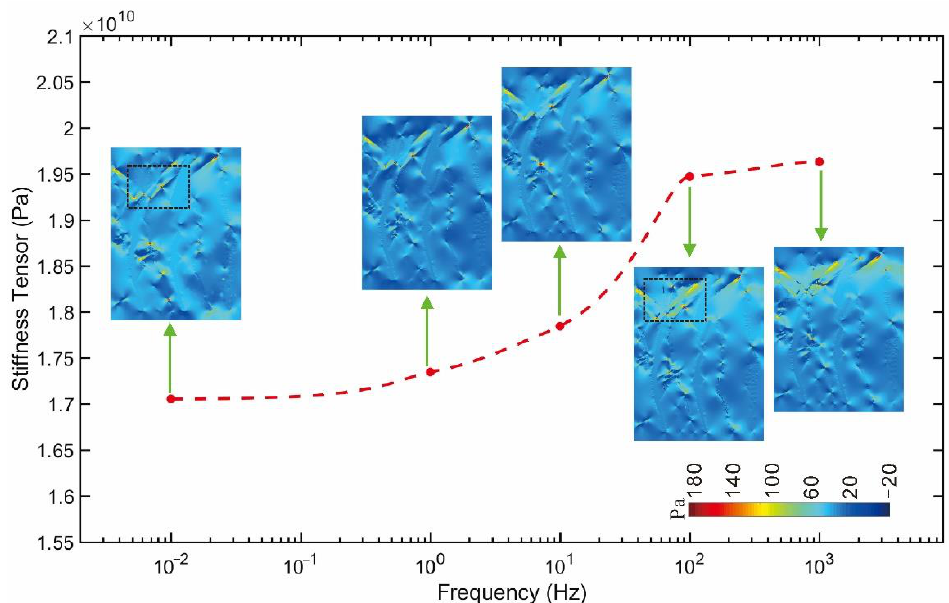
using these equivalent stiffness tensors.